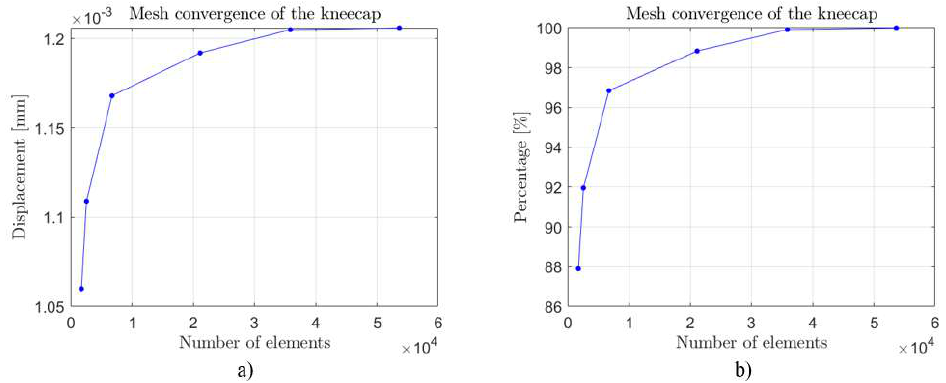
Figure 5. Exemplary results of mesh convergence: ( a ) results for kneecap displacement as a function of the number of elements; ( b ) displacement in the upper axis of the shock absorber as a function of the number of elements.